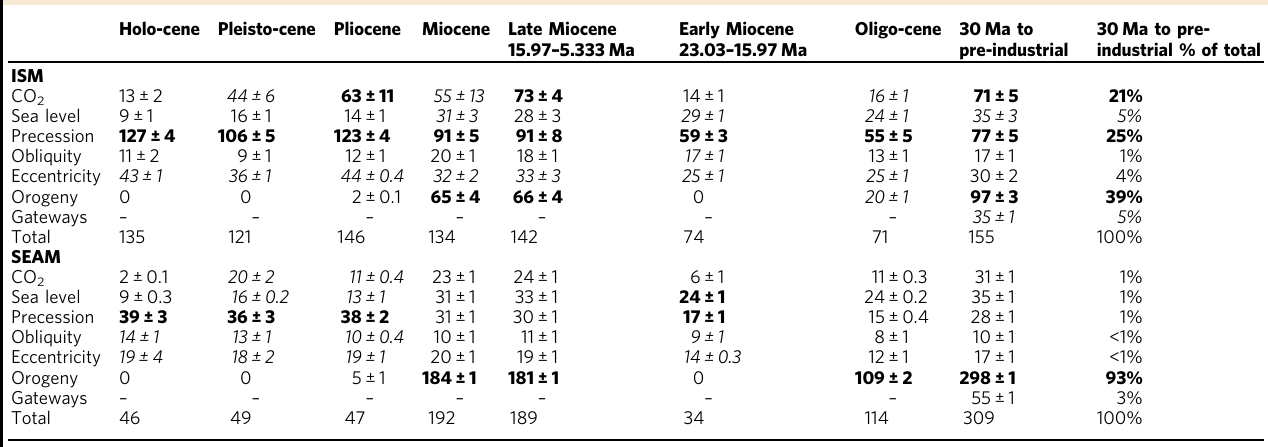
Table 1 Total effects on annual rainfall for each epoch (upper) ISM and (lower)